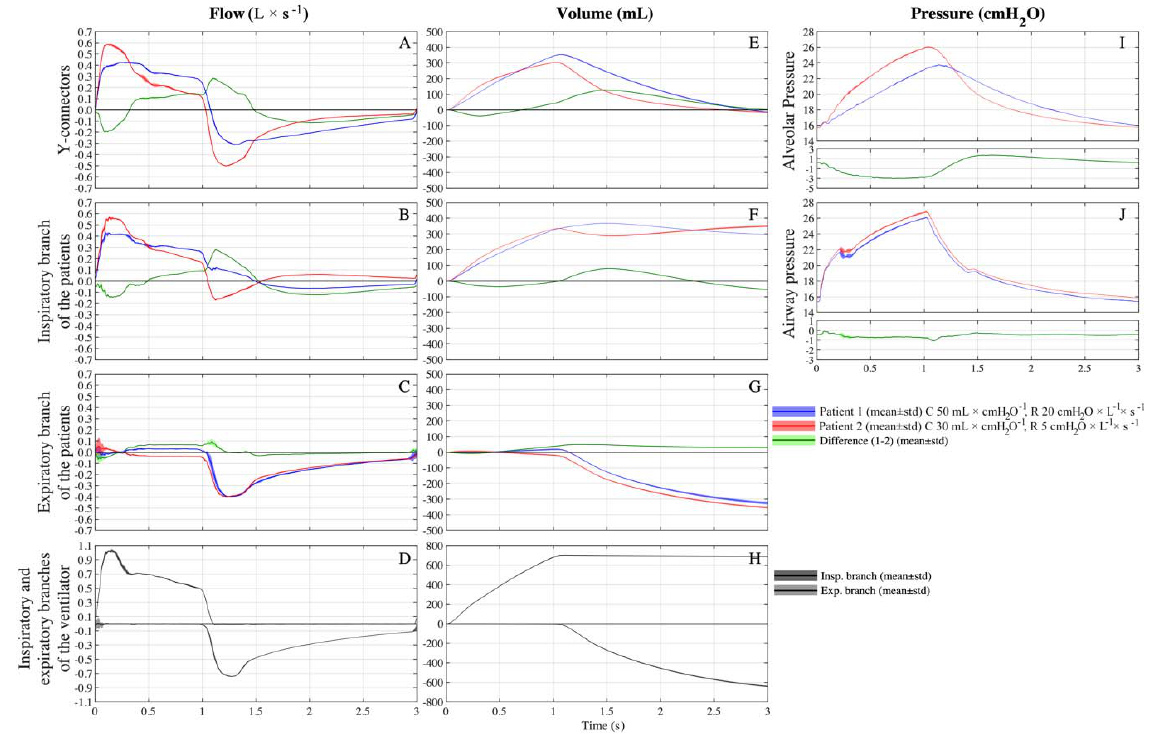
Figure 5. Average (continuous line) ± standard deviation (filled area plot) of multiple breaths of flows, pressures and volumes across the custom-made circuit on setting C 50-30/R 20-5 (C = 50 mL × cmH 2 O − 1 for patient 1, C = 30 mL/cmH 2 O for patient 2 and R = 20 cmH 2 O × L − 1 × s − 1 for both patients). Blue = patient 1, red = patient 2; green = difference between patient 1 and 2; dark grey = inspiratory branch of the ventilator; light grey = expiratory branch of the ventilator. ( A ) Flows at Y-connectors. ( B ) Flows at inspiratory branch of patients. ( C ) Flows at expiratory branch of patients. ( D ) Flows at inspiratory and expiratory branches of ventilator. ( E ) Volumes at Y-connectors. ( F ) Volumes at inspiratory branch of patients. ( G ) Volumes at expiratory branch of patients. ( H ) Volumes at inspiratory and expiratory branches of ventilator. ( I ) Alveolar pressures. ( J ) Airways pressures at HME.